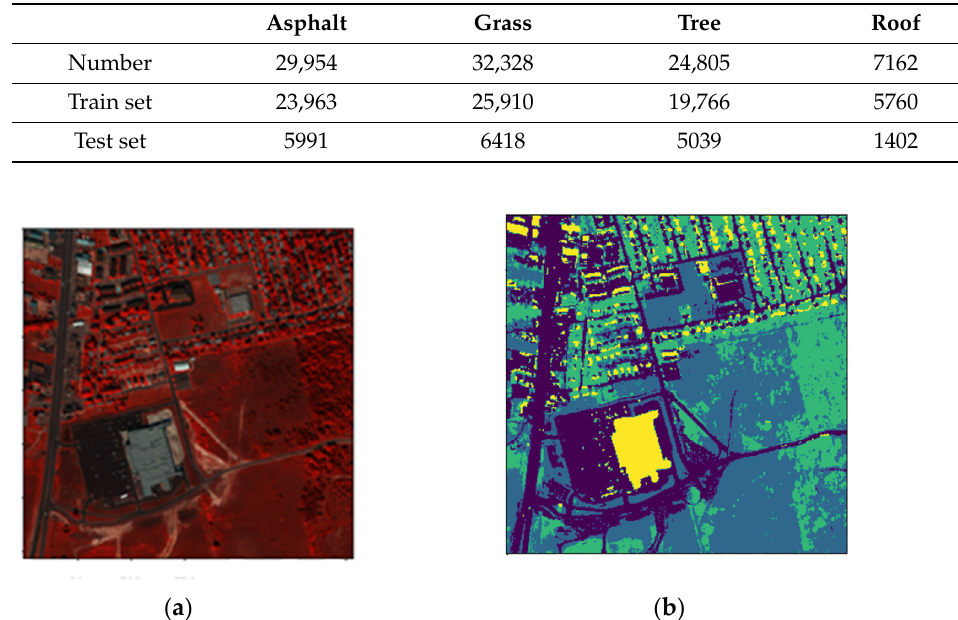
Figure 4. ( a ) Hyperspectral remote sensing image; ( b ) label image showing different terrains. Table 1. Train and test sets of the